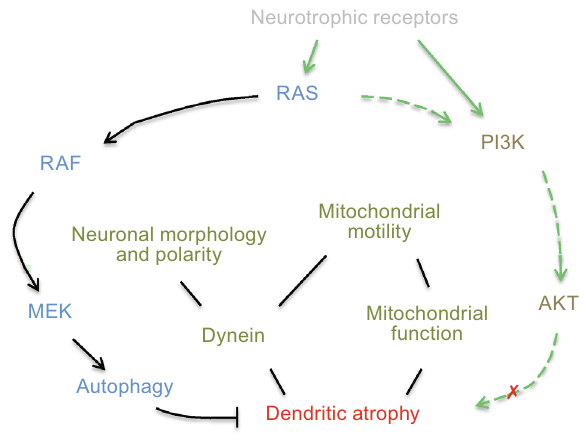
Figure 6. Schematic summary of general roles of RAS-RAF- MEK pathway in protecting dendritic atrophy caused by dynein malfunction or mitochondrial